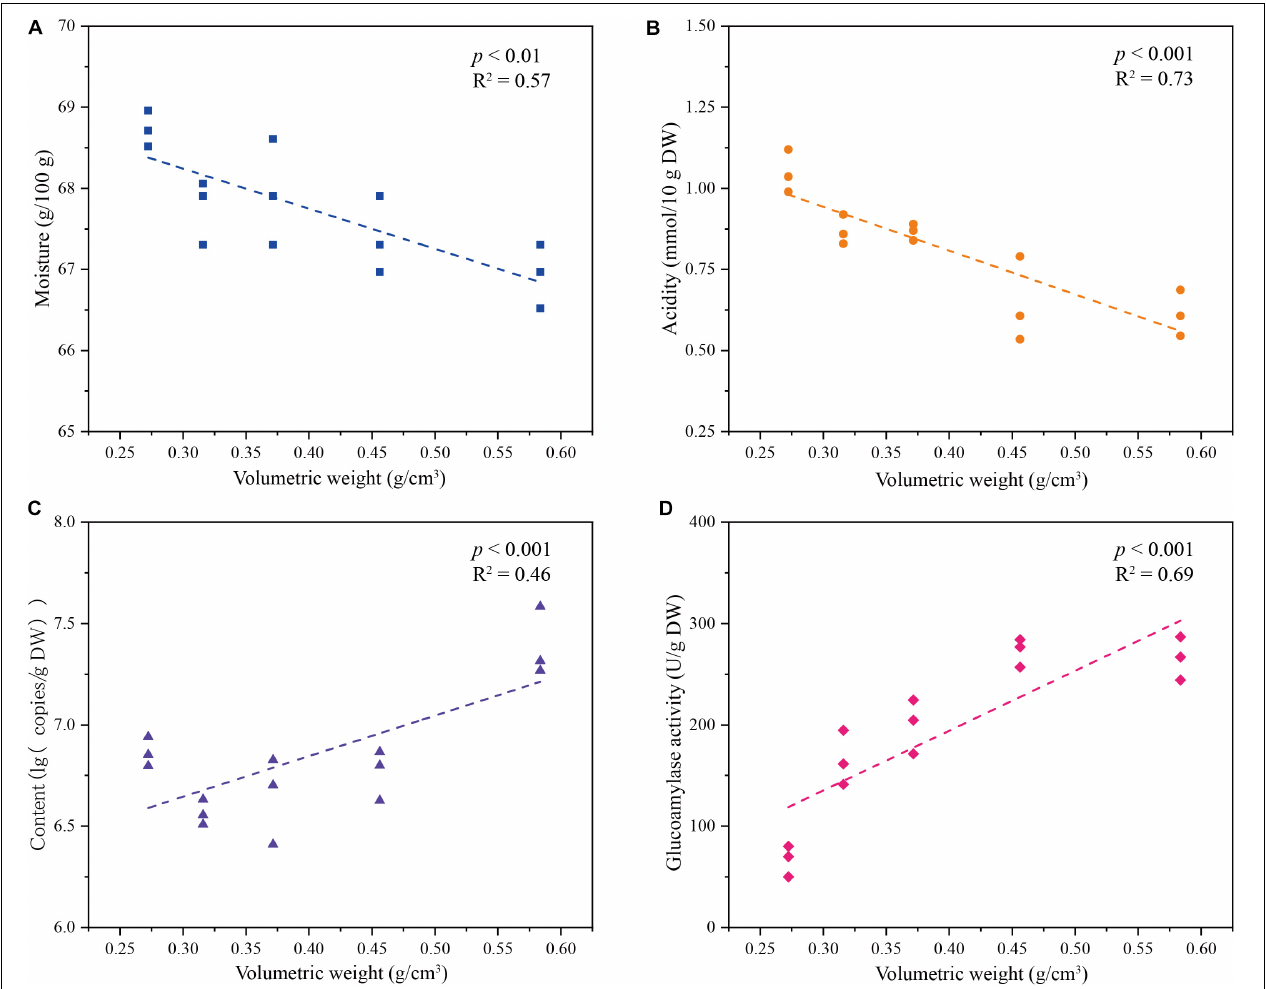
FIGURE 5 | Dynamics of (A) moisture, (B) acidity, (C) microbial population, and (D) glucoamylase activity in Single-strain Jiuqu under different volumetric weight